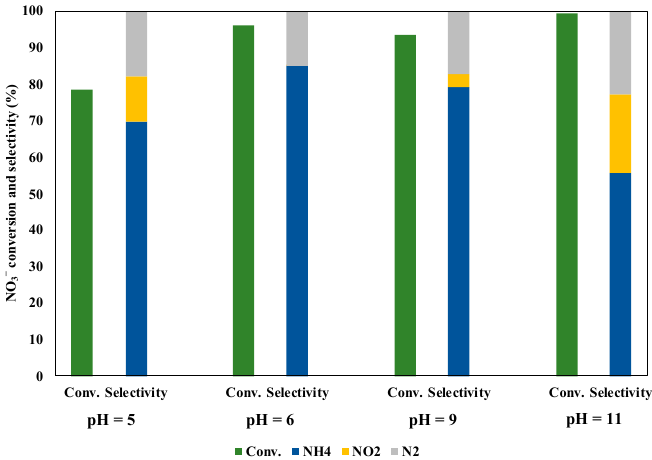
Figure 11. pH e ff ect in solution during NO 3 − reduction under UV irradiation for three hours.